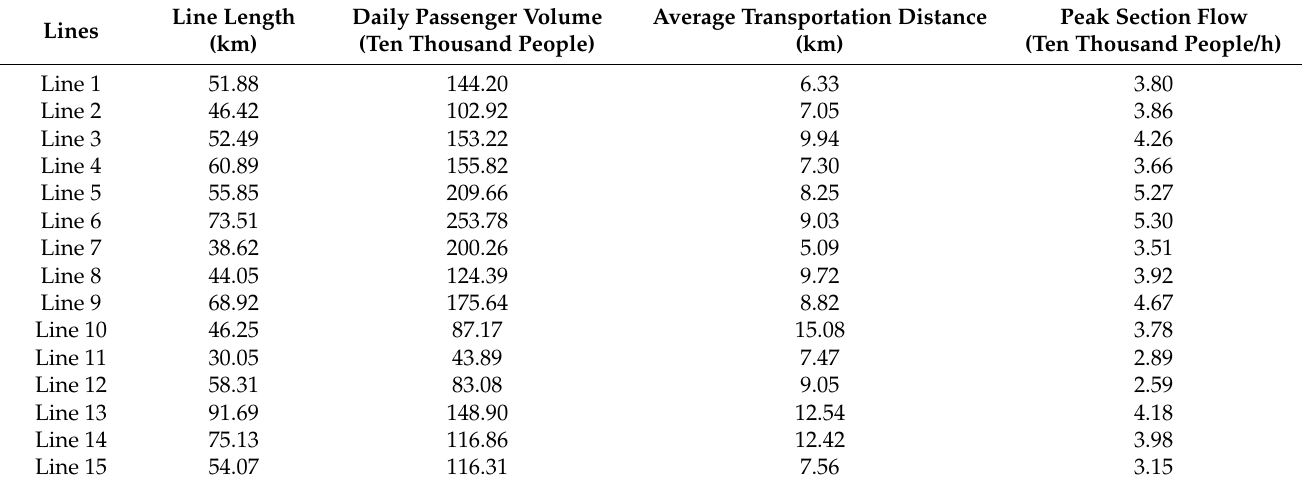
Table A2. Forecast data from the Chengdu Metro Network Planning Report